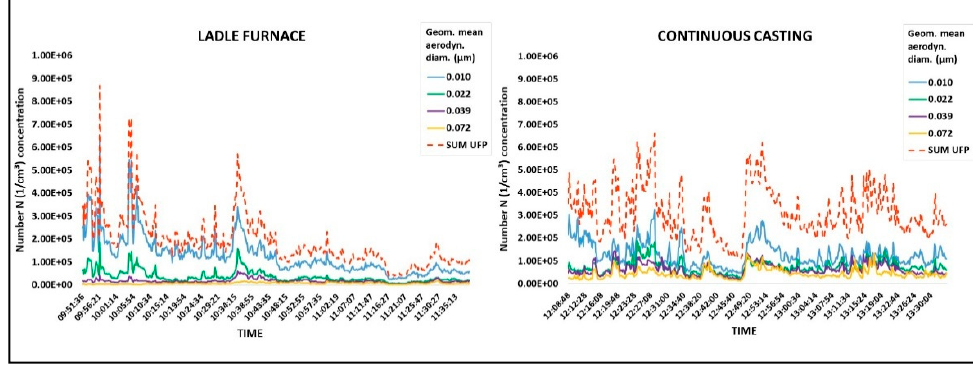
Figure 4. Time variation of ultrafine particle (UFP) number concentrations (part/cm 3 ) by size measured by ELPI next to ladle furnace and continuous casting. x -axis represents sampling (hh:mm:ss) and y -axis represents UFP number concentration (1/cm 3 ).